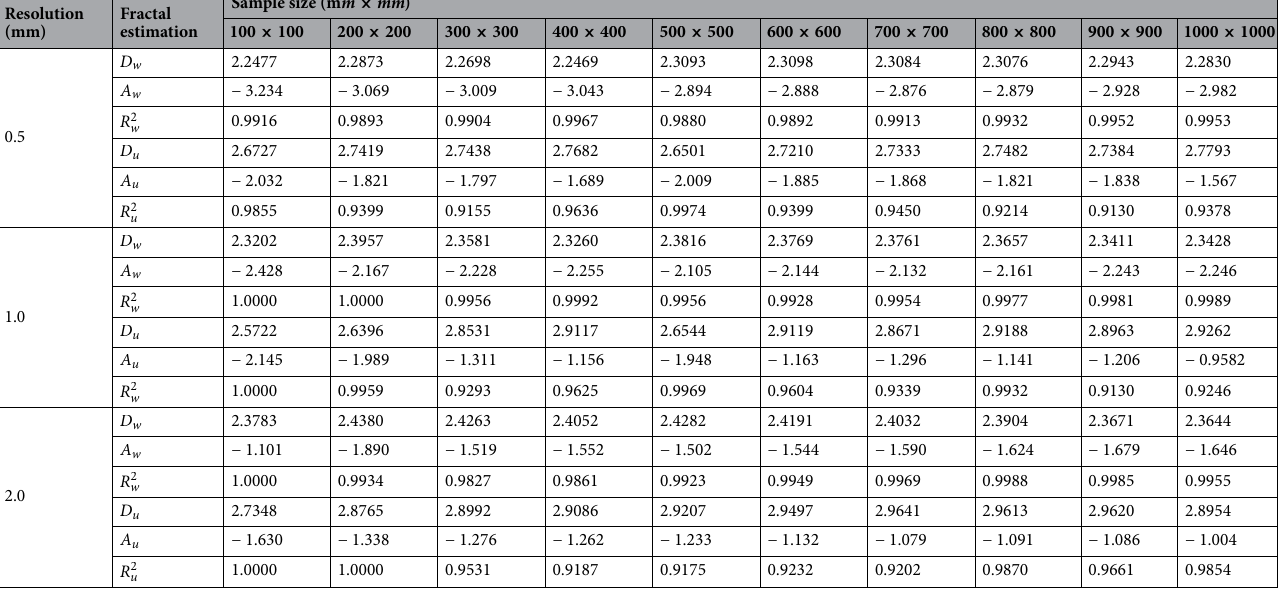
Table 3. Fractal dimensions of waviness and unevenness of rock joint sample S3 at varying sample sizes. D w and D u are fractal dimensions of waviness and unevenness, respectively. A w and A u are the coefficients during linear correlation for estimating D w and D u , respectively. R during linear correlations for estimating D w and D u ,